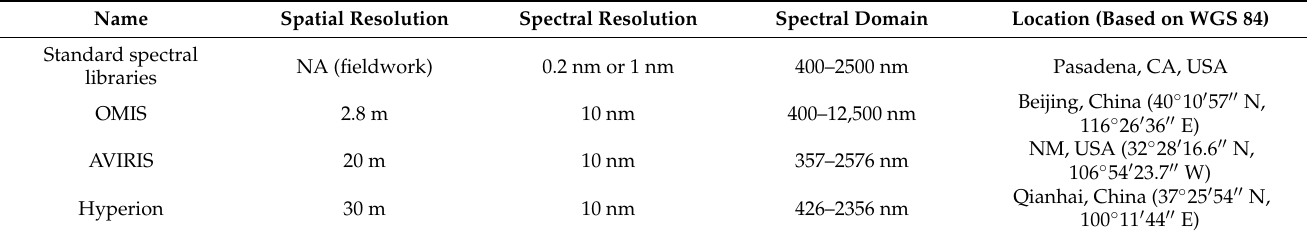
Table 1. The details of data used in this paper.